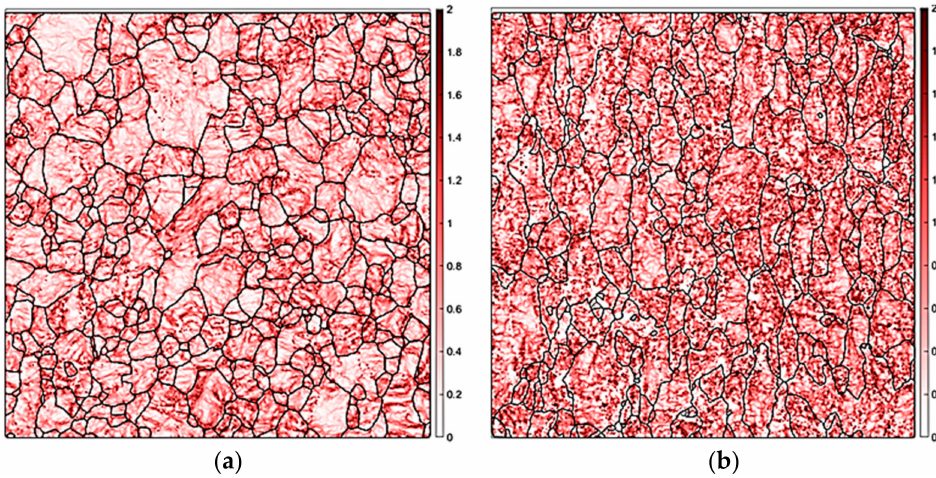
Figure 3. KAM maps of the CR20 ( a ) and CR50 alloys ( b